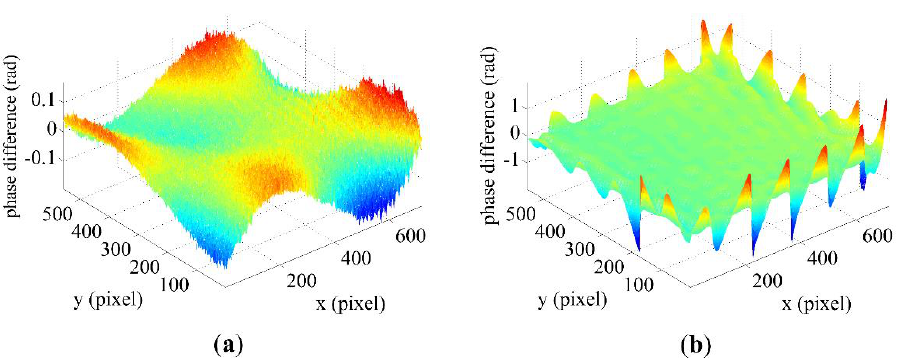
Figure 12. Reconstructed phase difference distribution of the tested standard plane by ( a ) TFTP and ( b ) traditional FTP.